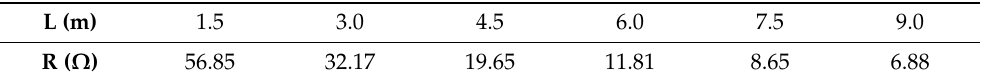
Figure 6. Detail on the rod sections junction. Table 4. Buried rod length L (m) and the corresponding simulated grounding resistance R ( Ω ) for the considered synthetic soil when a non-zero internal resistance rod is driven into the soil.